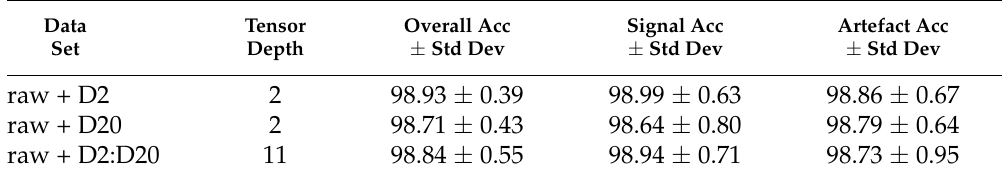
Table 7. CNN model performance for raw data combined with wavelet set. Results have been estimated using repeated k-fold validation (5 rounds with 5 folds each).